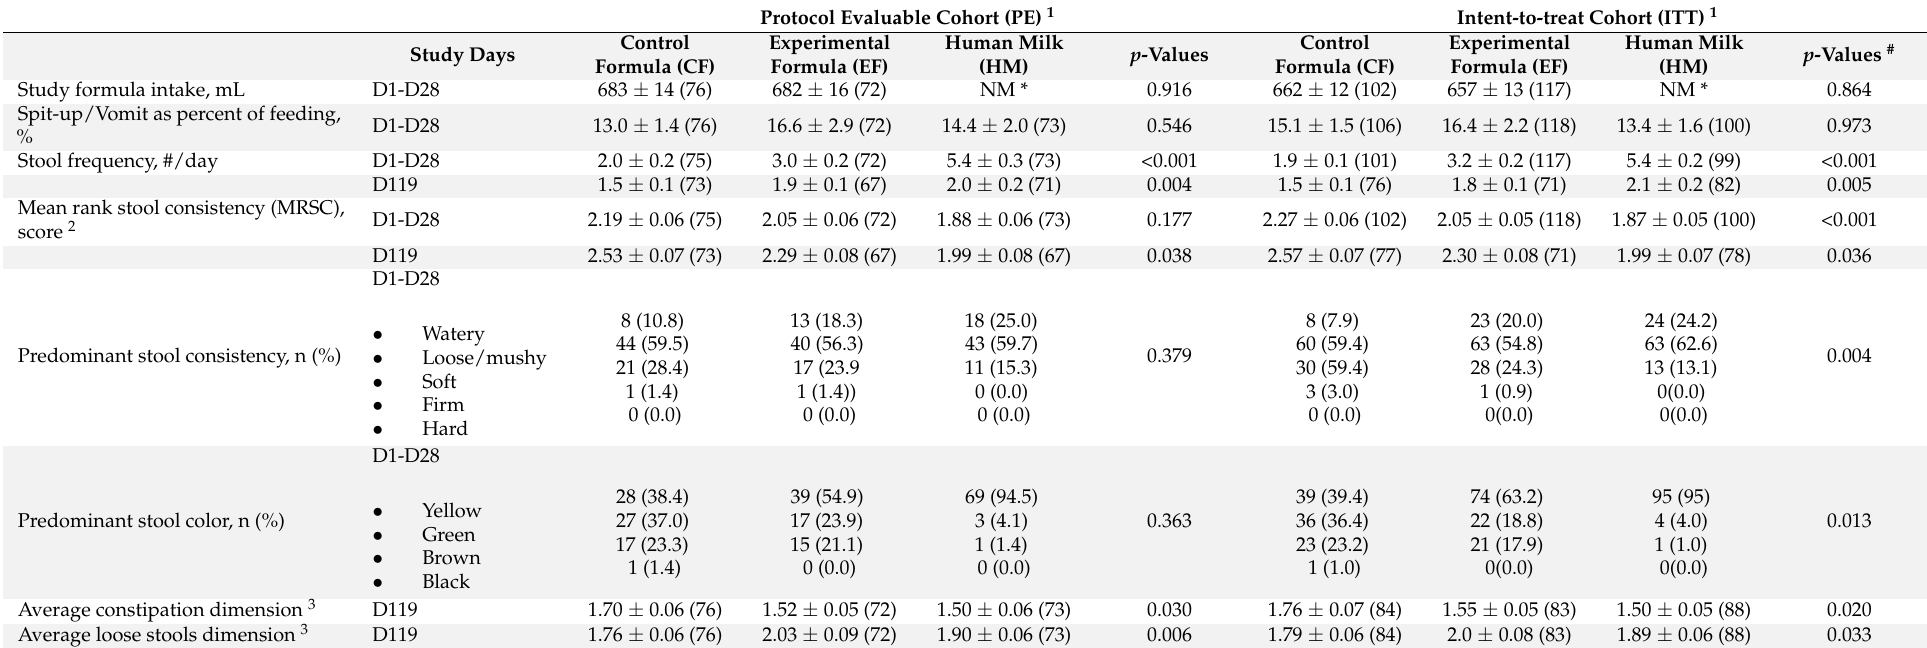
Table 3. Formula intake and GI stool